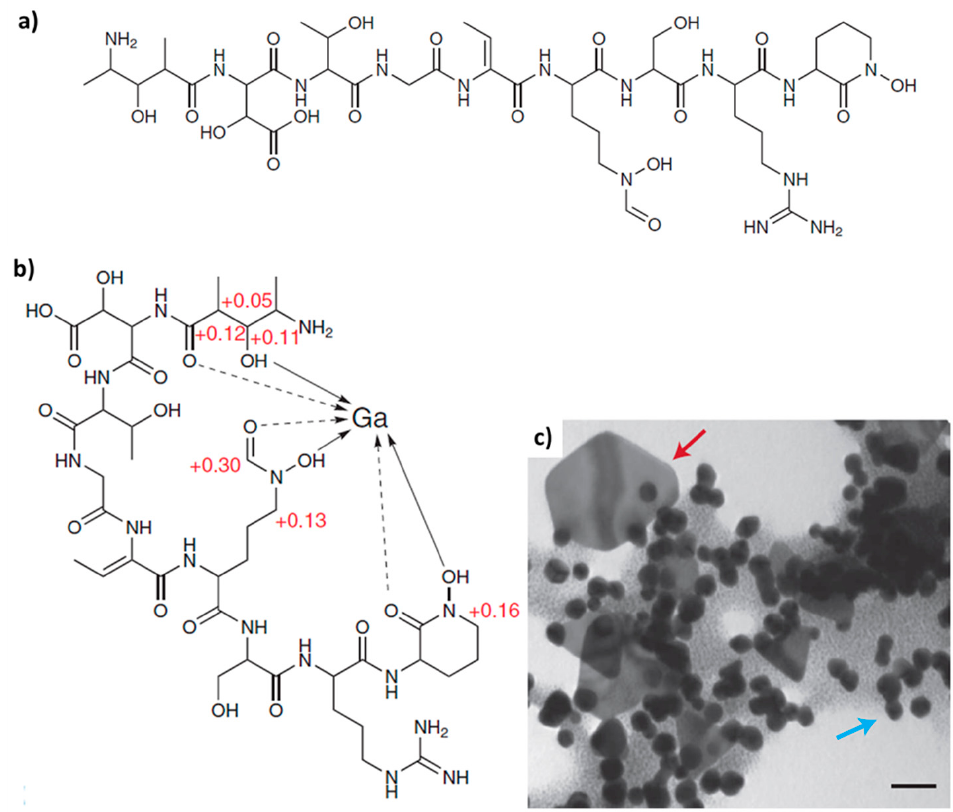
Figure 2. ( a ) Structure of defltibactin A , ( b ) Gallium NMR confirms that delftibactin has a single metal-binding site. ( c ) TEM of delftibactin–gold (2:1) complex after 10 min reveals the presence of colloidal and octahedral gold nanoparticles, reminiscent of those seen in natural deposits. Blue arrow, colloidal gold. Red arrow, octahedral gold. (Scale bar 50 nm). Reprinted with permission from Macmillan Publishers Ltd: Nature Chemical Biology [55], copyright